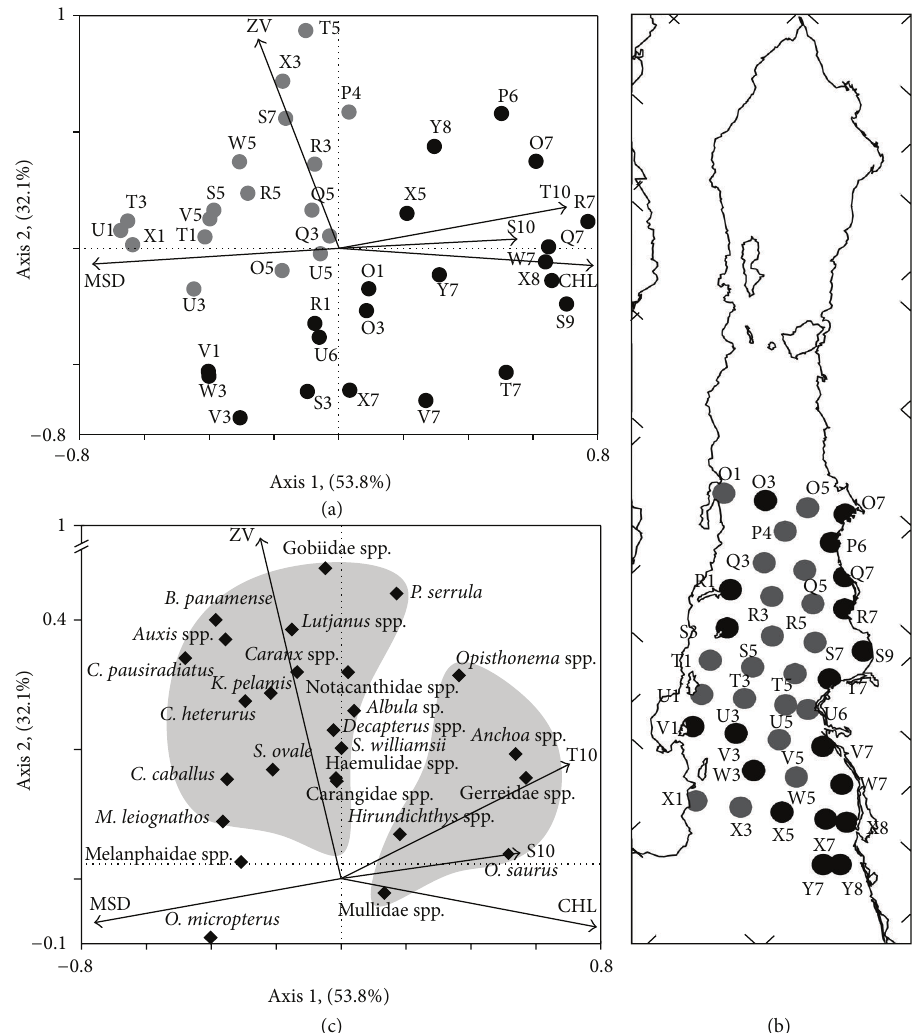
Figure 9: Classification and ordination analysis: September. (a) RDA biplot of sampling stations-environment, black circles = SeG1; grey circles = SeG2. (b) Distribution of stations groups resulting from RDA. (c) RDA biplot